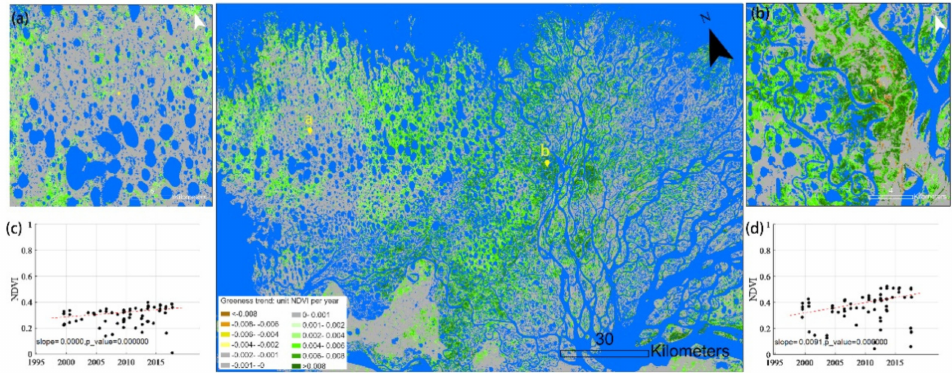
Figure 7. The NDVI trend details of a 200 km × 100 km area at the Lena River delta, Northern Yakutia, Russia, from 1984 to 2018: ( a ) NDVI stable site (73.503 ◦ N, 124.428 ◦ E); ( b ) greening site (73.074 ◦ N, 126.655 ◦ E); ( c ) the Landsat NDVI time series of location a; ( d ) the Landsat NDVI time series of location